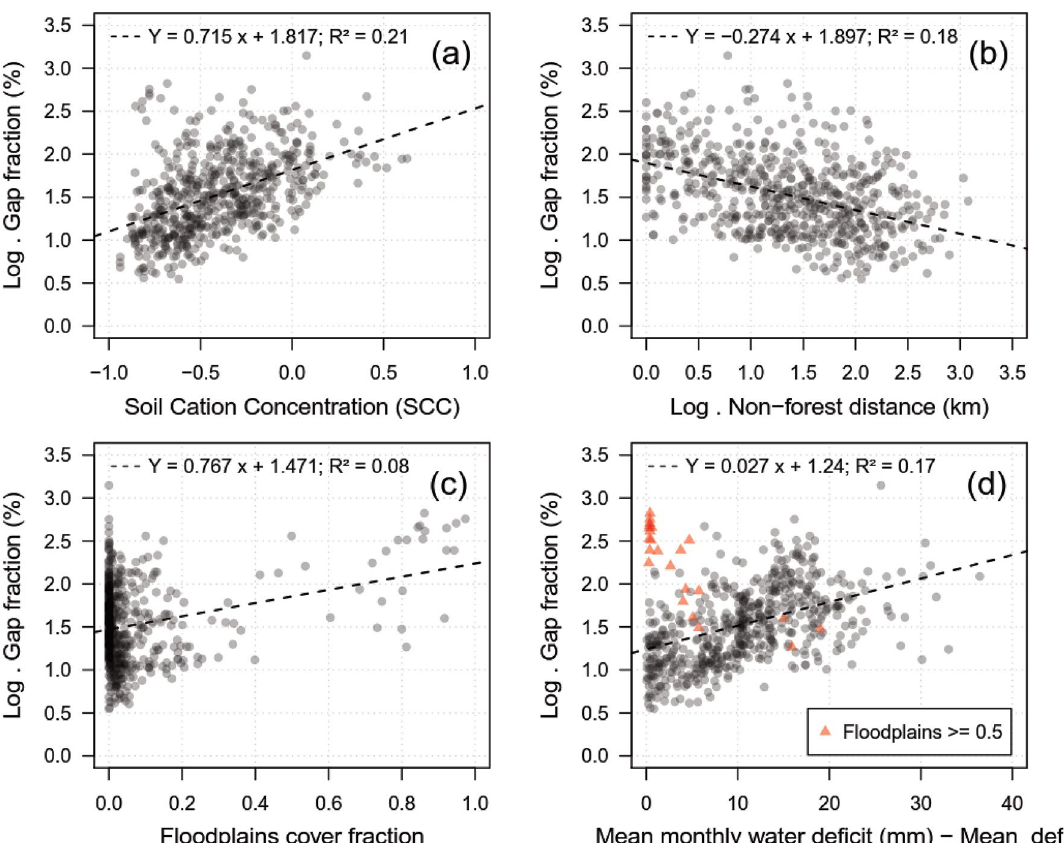
Figure 4. Relationships between gap fraction (log-scale) and predictors used in the final model. ( a ) Soil cation concentration (SCC). ( b ) Non-forest distance (km) (log-scale). ( c ) Floodplains cover fraction. ( d ) Mean monthly water deficit (mm)— Mean_def . Red triangles on panel ( d ) represent samples with floodplains cover fraction ≥ 0.5. The dashed line represents a linear